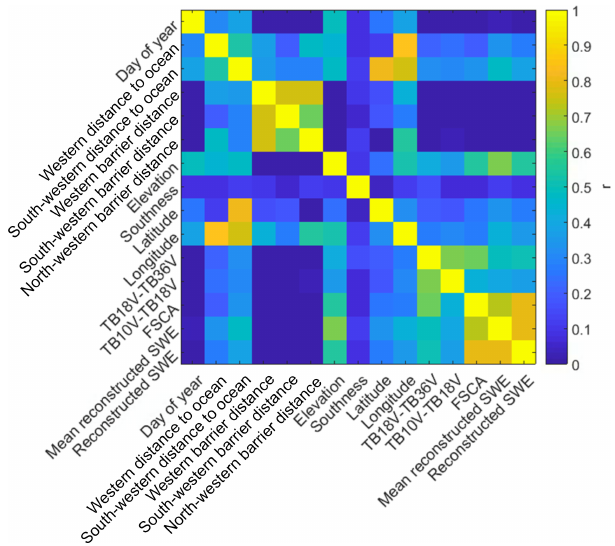
Figure 7. Correlation coefficient ( r) for all variables, sampled ran- domly across all